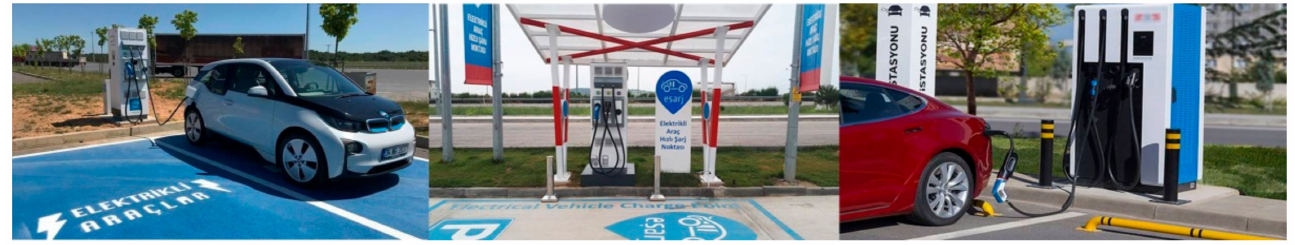
Figure 2. Examples of EVCSs in